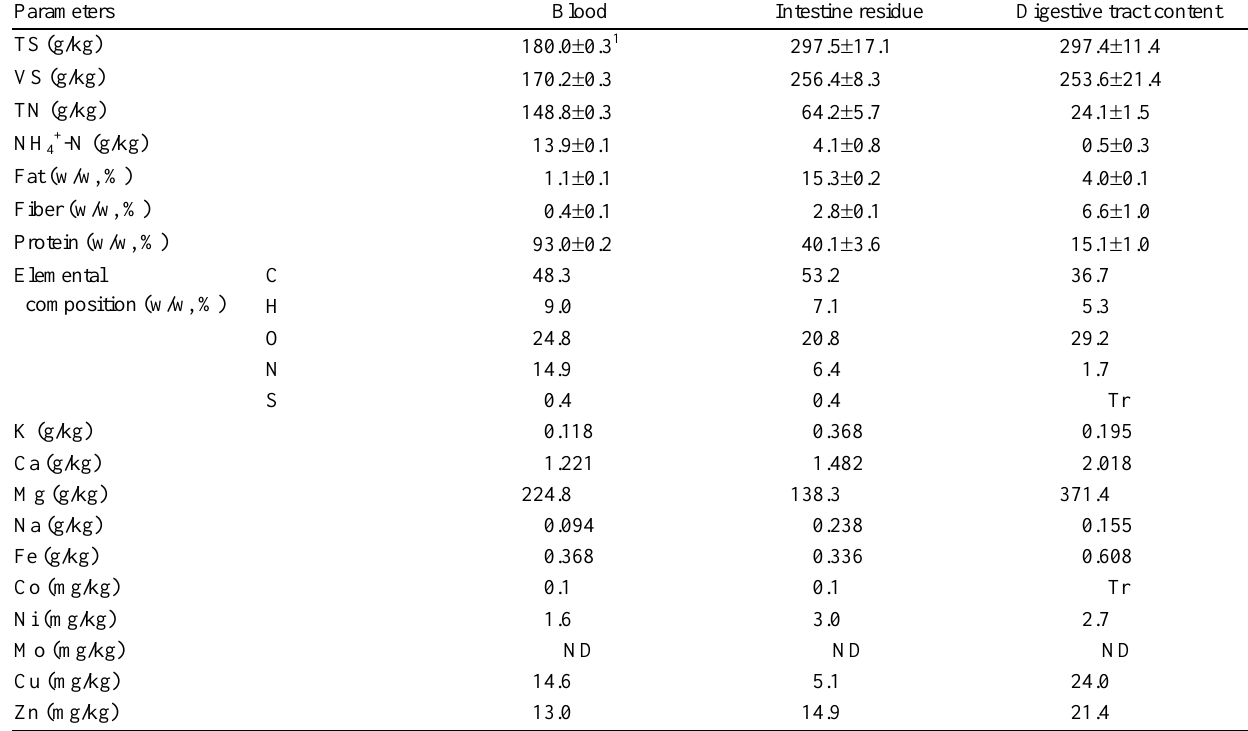
Table 3. Characteristics of piggery slaughterhouse wastes